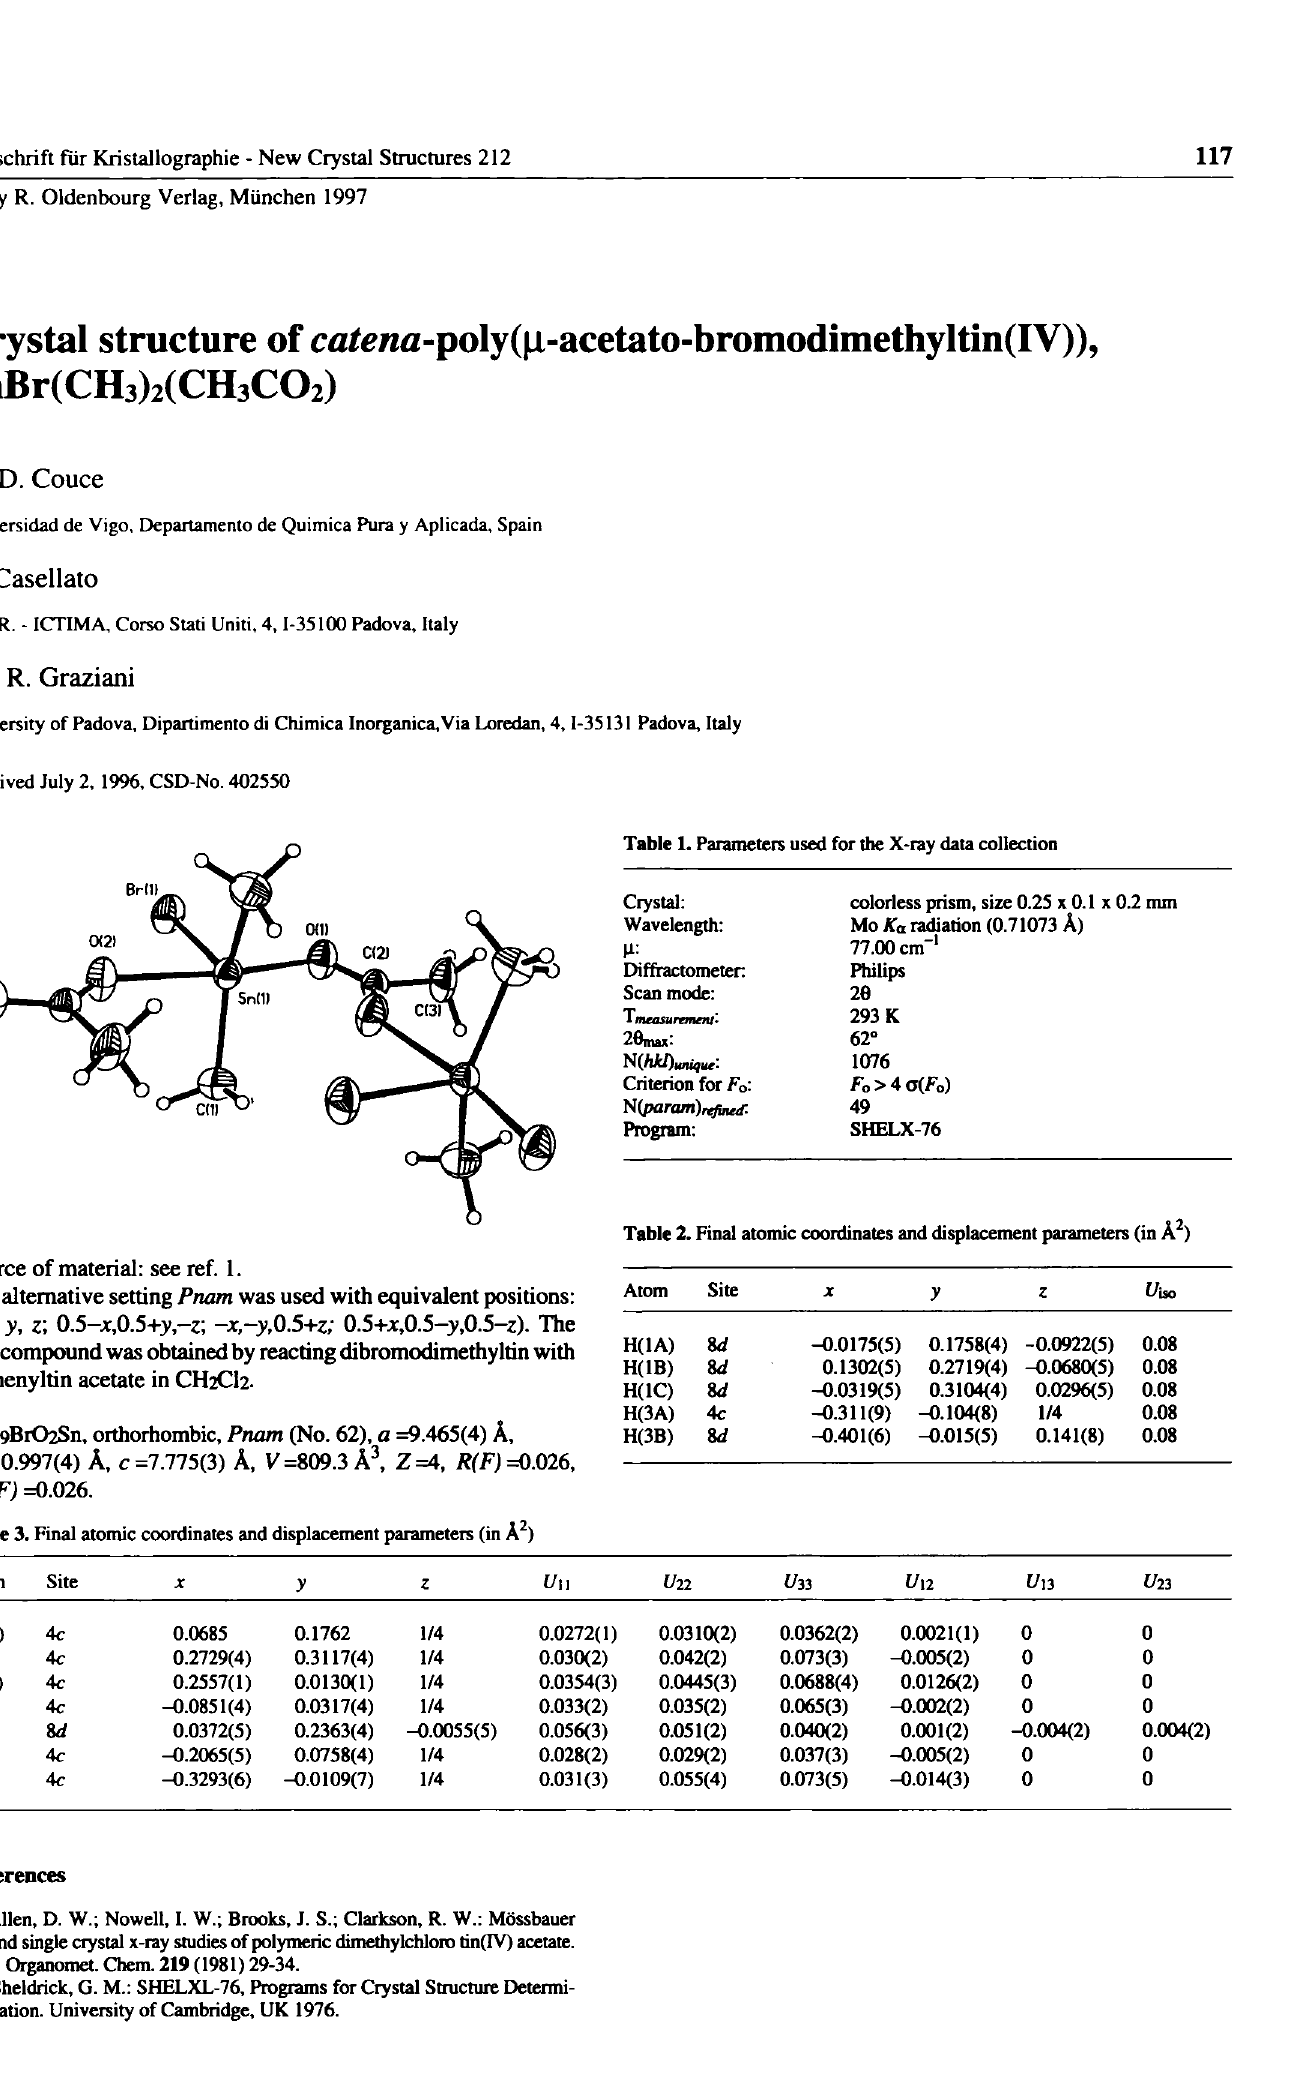
Table 2. Final atomic coordinates and displacement parameters (in A 2